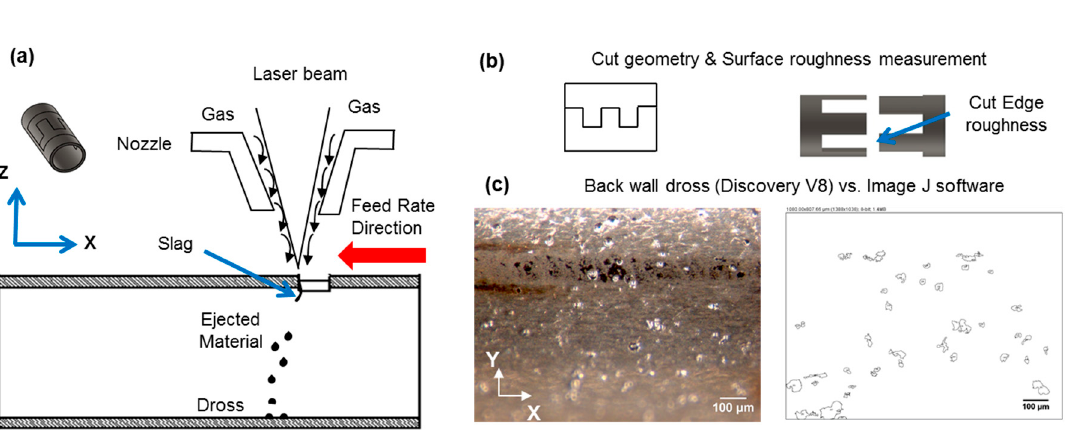
Figure 2. Back wall dross and surface roughness measurement. ( a ) Schematic representation of laser beam action and dross deposition on back wall. ( b ) Drawing of the cut geometry and representation of the surface roughness measurement on the cut edge. ( c ) Macrograph of the analyzed back wall area with adhered dross (Discovery V8) versus processed image (ImageJ) showing the area of individual dross particles.